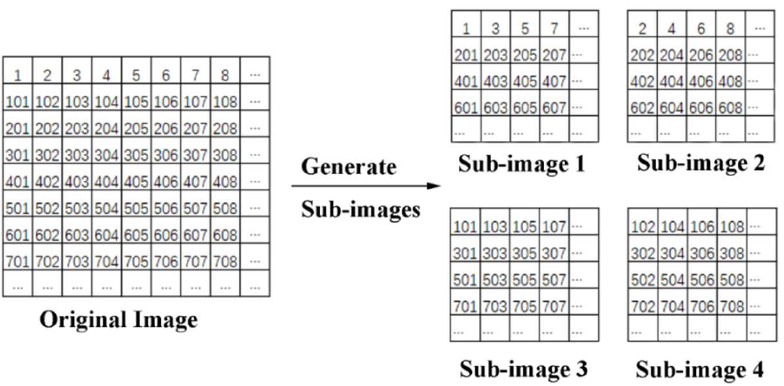
Figure 2. Schematic diagram of sub-image generation with a sampling scale of 2.